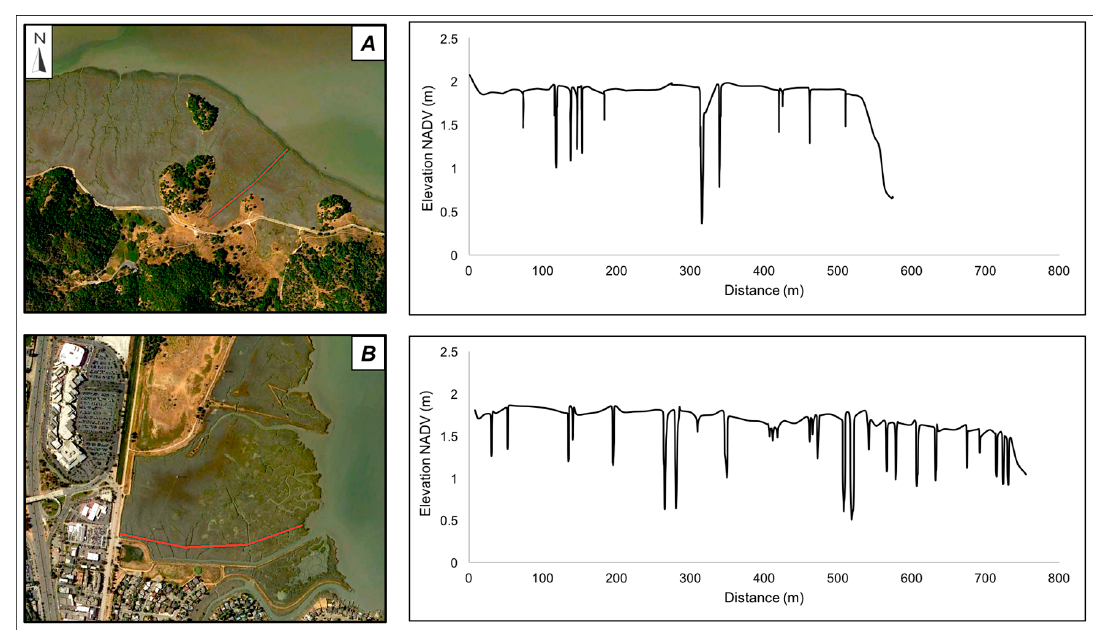
Figure 2. Google Earth aerial imagery for China Camp ( A , reference site) and Muzzi Marsh ( B , restoration site). The total transect length was 574 m at China Camp and 754 m at Muzzi Marsh. Mean elevation of the marsh plain (excluding channels) was 1.850 m (NADV 88) at China Camp and 1.677 m (NADV 88) at Muzzi Marsh. Sampling at both sites began in 1990 and was performed for most years through 2005. Both sites are tidal and receive no substantial freshwater from the surrounding landscape. The study area at China Camp is part of the China Camp State Park and is surrounded by protected oak woodland and grassland, while the study area at Muzzi Marsh is part of the Corte Madera Ecological Reserve and is surrounded largely by urban development.